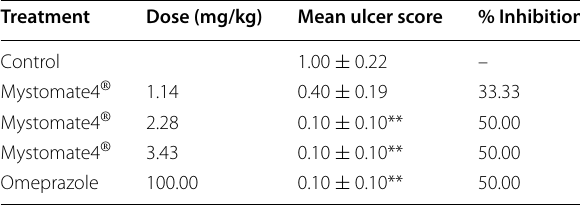
Results are mean SEM, n 5. Statistical comparison was determined by ± = one way ANOVA followed by Tukey’s multiple comparison tests. ** P < 0.01, statistically significant compared to control